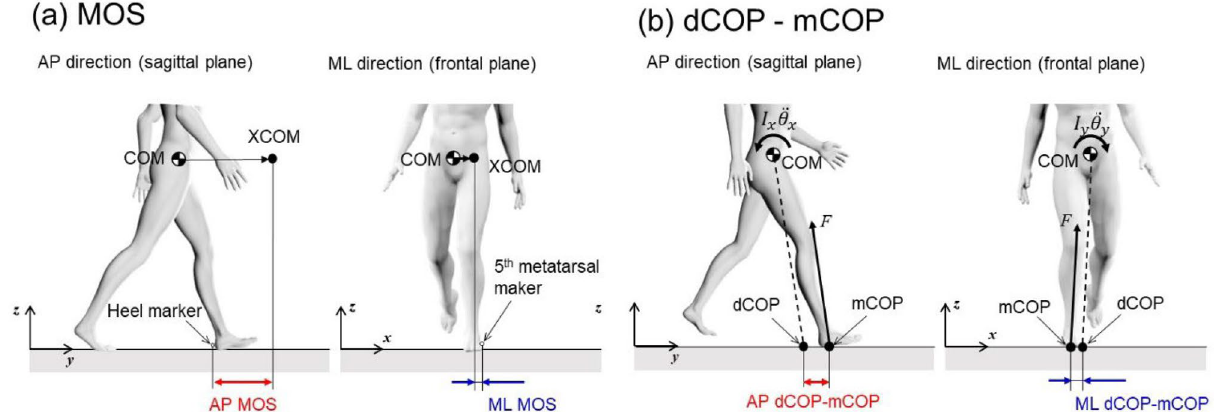
Figure 4. Schematic of the ( a ) margin of stability and ( b ) dCOP location with respect to mCOP in the AP and ML directions. dCOP desired center of pressure; mCOP measured center of pressure; AP anteroposterior; ML mediolateral.